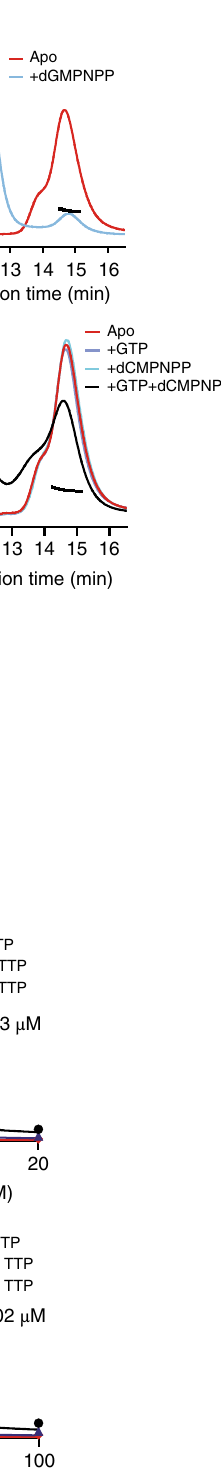
order of increasing af fi nity: dAMPNPP < TMPNPP < dCMPNPP < dGMPNPP (Fig. 1c and Supplementary Table